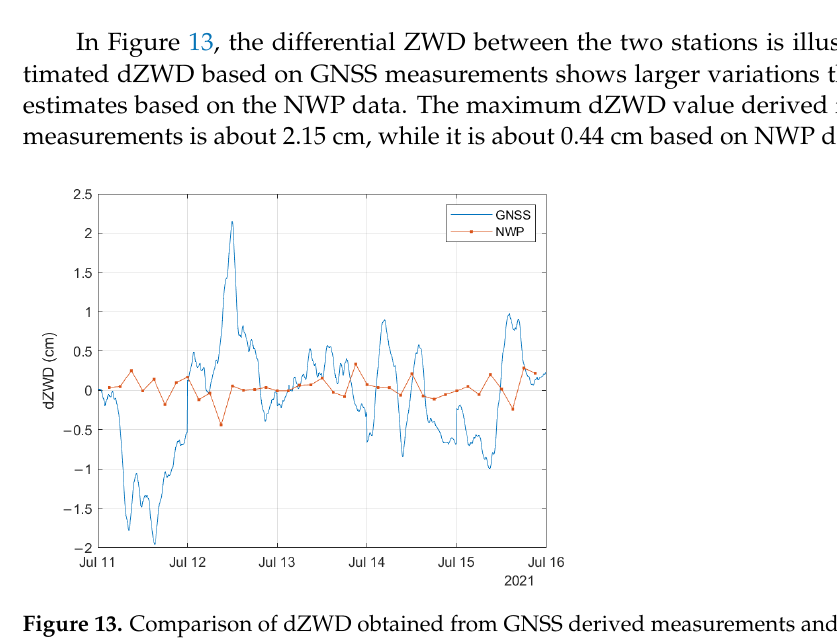
Figure 13. Comparison of dZWD obtained from GNSS derived measurements and NWP